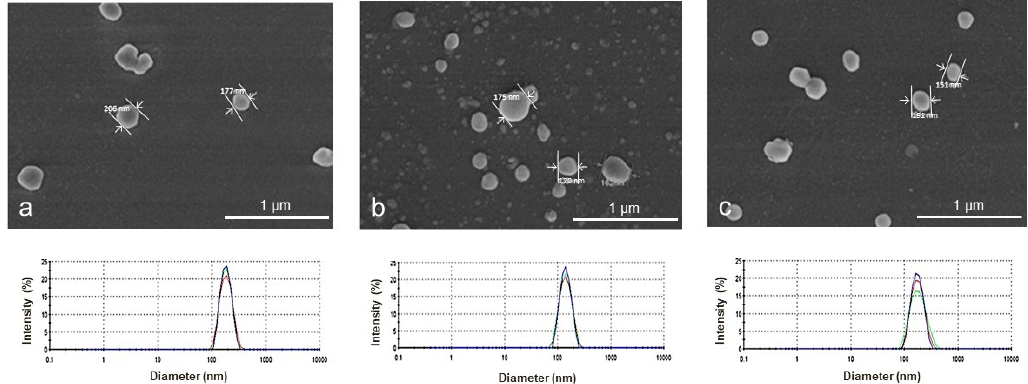
Figure 2. Representative scanning electron micrograph (SEM) and particle size distribution (DSL) of HEMA/Bayfit-MA NPs. Images obtained from dried (SEM) and aqueous dispersions (DSL) of NP1: ( a ) NP1 (HEMA/Bayfit-MA 99:1 w / w ); ( b ) NP5 (HEMA/Bayfit-MA 95:5 w / w ); and ( c ) NP10 NP1: ( a ) NP1 (HEMA / Bayfit-MA 99:1 w / w ); ( b ) NP5 (HEMA / Bayfit-MA 95:5 w / w ); and ( c ) NP10 (HEMA / Bayfit-MA 90:10 w / w